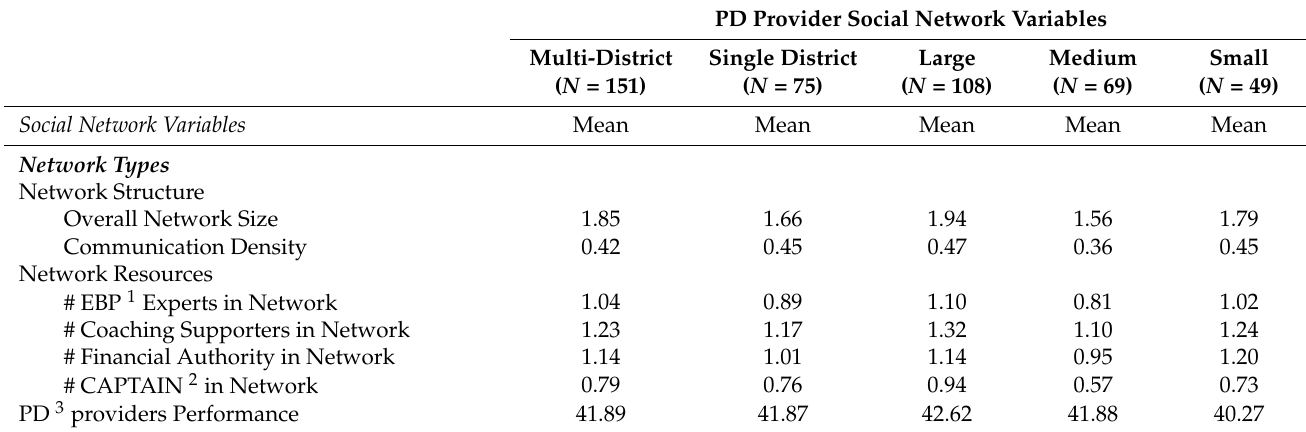
Table 2. PD provider network characteristics.